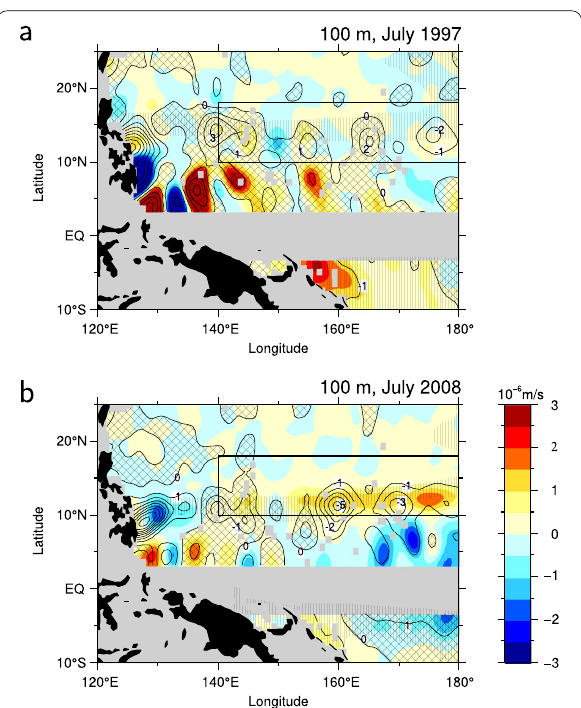
Fig. 16 Distributions of eastward velocity u ( cms − 1 , contours) and northward velocity v ( cms − 1 , color shading) averaged within isopycnal layers of 25.0 and 25.5 σ θ in a July 1997 and b July 2008, i.e., periods of the weak and strong upward transports in Region A (solid square), which are denoted by upward and downward arrows in Fig. 14a, respectively. Data were smoothed by a 15-month running mean filter. Contour intervals of u are 5 cms − 1 and dashed contours indicate negative values (westward